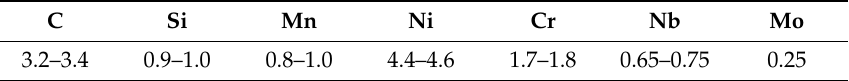
Table 1. Chemical composition range of the working layer.